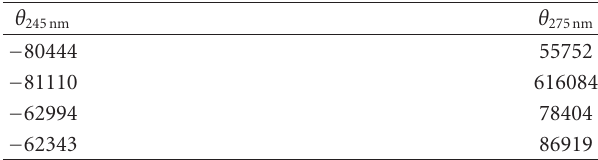
Table 1: E ff ects of Pt complex on the CD spectra of DNA, in tris HCL bu ff er.